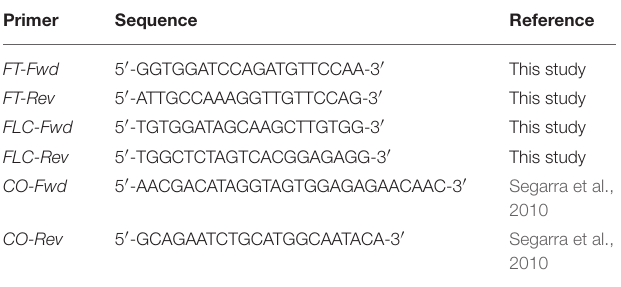
TABLE 1 | Primers for